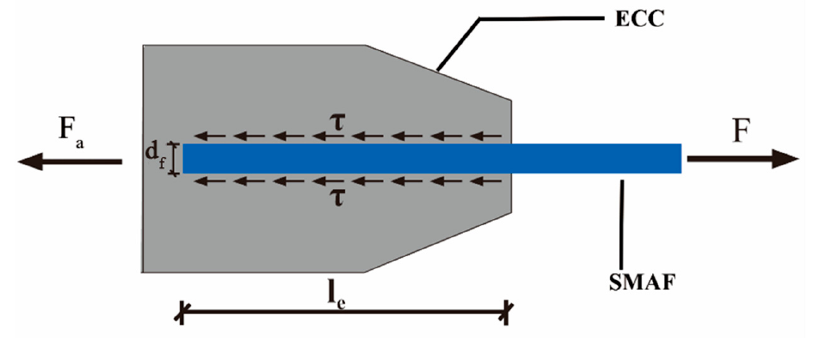
Figure 12. The force balance diagram of the SMA fiber during the pullout process.